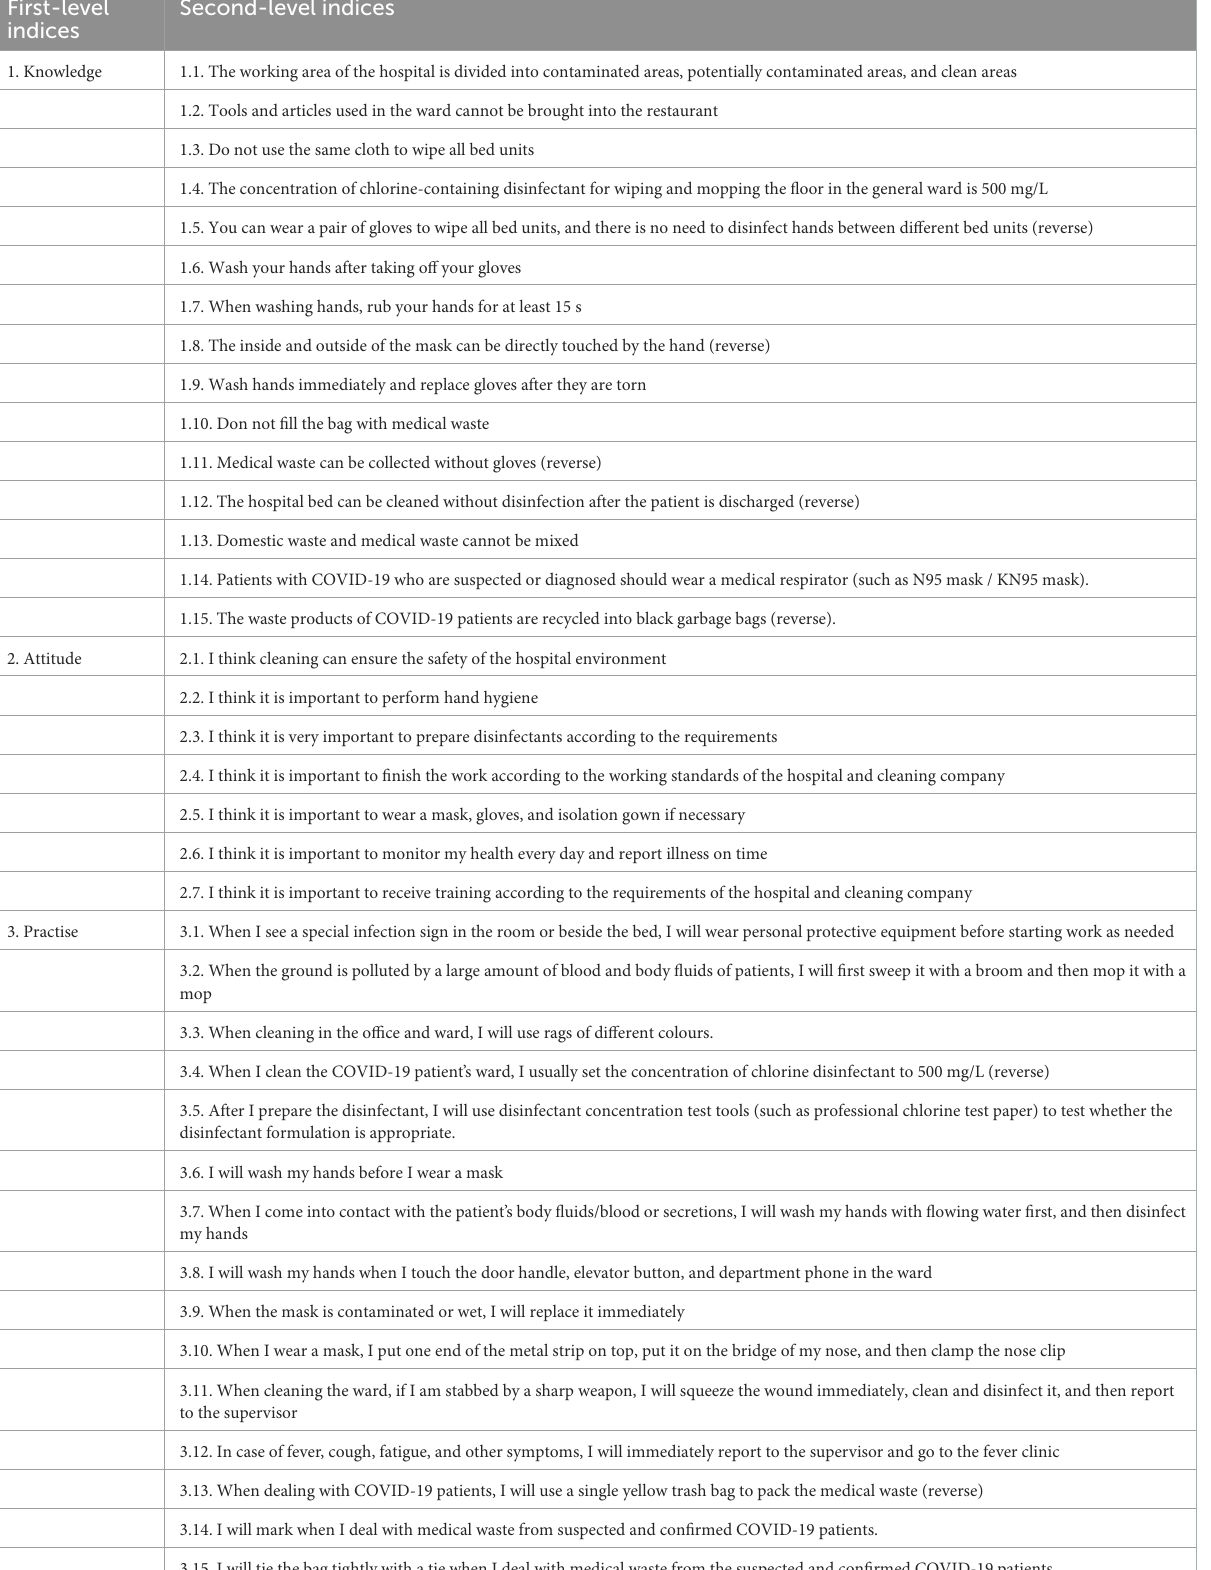
TABLE 5 Final tool. First-level